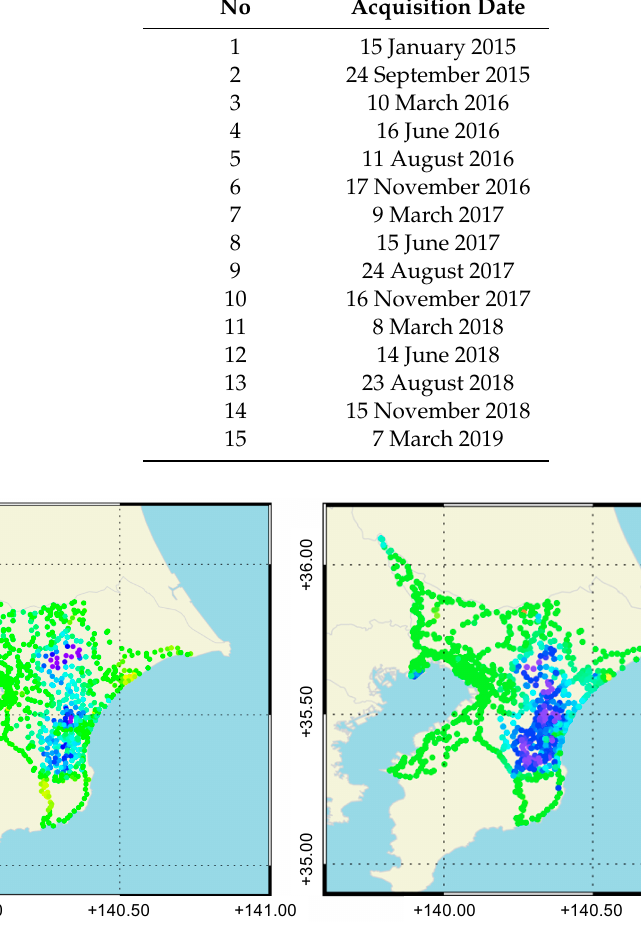
Figure 2. Mean subsidence velocity acquired from the levelling data for Chiba Prefecture from 2015 to 2019 ( left ) and from 2006 to 2010 ( right ).